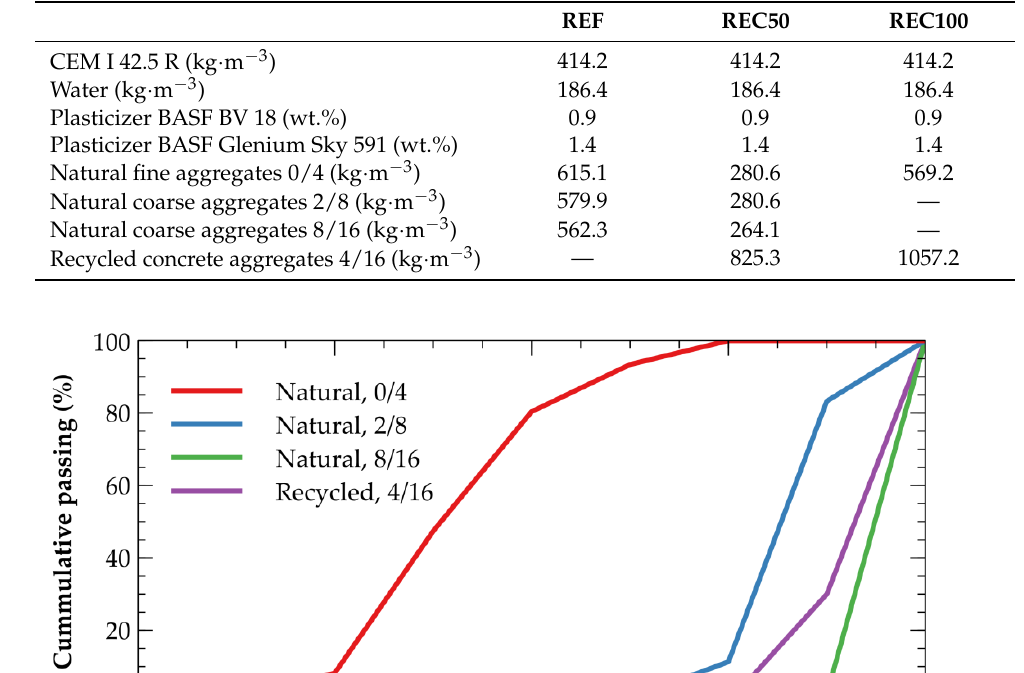
Table 1. Summary of mixture compositions.